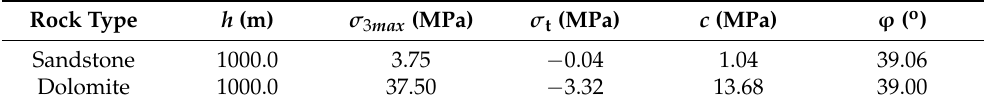
Table 4. The results of calculations based on the Coulomb–Mohr strength criterion.